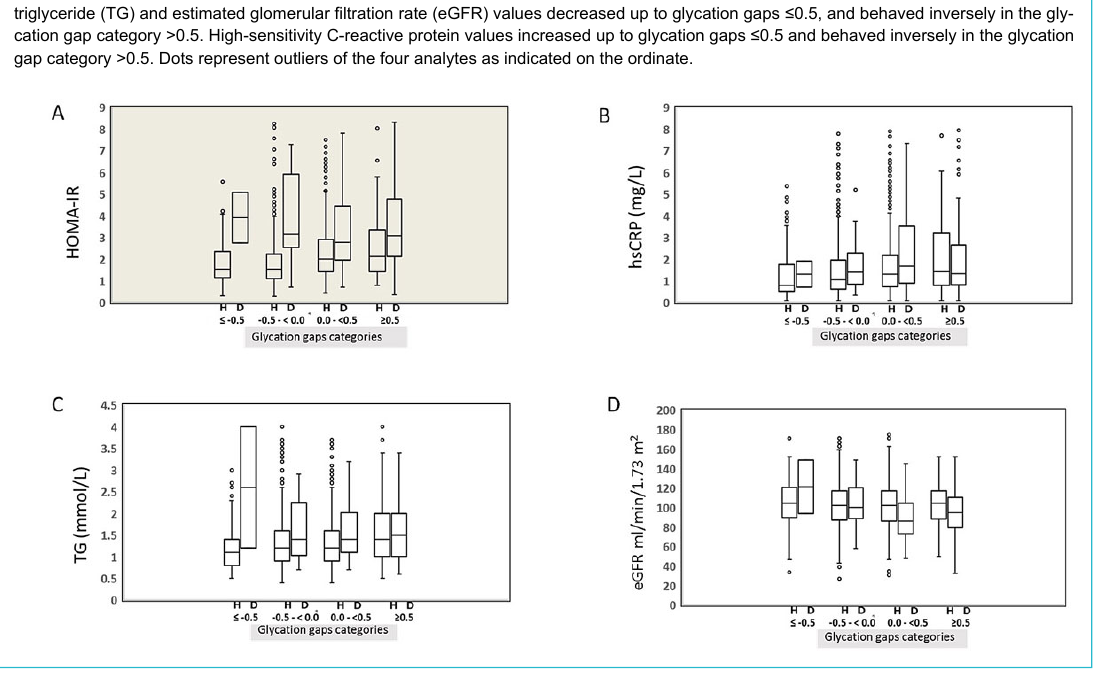
Figure 2: Variations in homeostasis model assessment for estimation of insulin resistance (HOMA-IR), high-sensitivity C-reactive protein (hsCRP), triglyceride (TG) and glomerular filtration rate levels according to glycation gap category and diabetic status.Statistical box and whiskers diagram around median values. (A) Differences between healthy (H) and diabetic (D) participants were calculated with chi-square and Mann-Whitney tests, as appropriate; (B) hsCRP, high-sensitivity C-reactive protein; (C) TG, triglyceride; (D) GFR, glomerular filtration rate. As can be seen from the figure, in healthy participants, homeostasis model assessment for estimation of insulin resistance (HOMA-IR), high- sensitivity C-reactive protein (hsCRP) and triglyceride (TG) values increased with glycation gap category (p<0.001). In diabetic participants, differences between healthy and diabetic participants were calculated with chi-square and Mann-Whitney tests, as appropriate.HOMA-IR, triglyceride (TG) and estimated glomerular filtration rate (eGFR) values decreased up to glycation gaps ≤0.5, and behaved inversely in the gly-